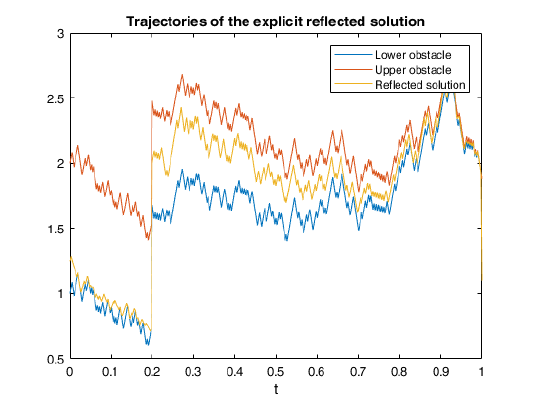
Figure 6. One path of ˜ y n in the explicit reflected scheme ( τ =